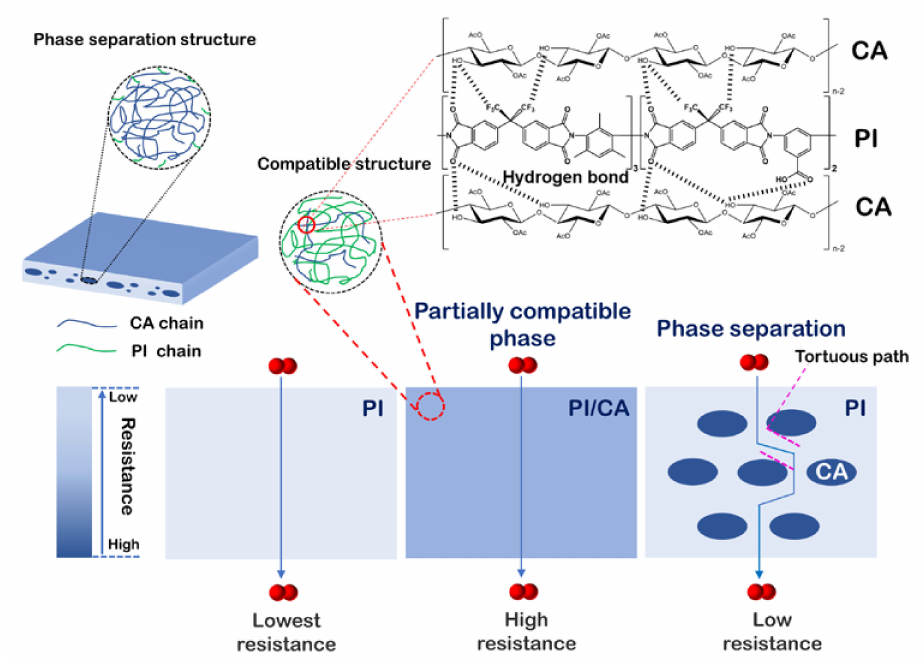
Figure 5. The mechanism of gas permeability of different phase structures for composite